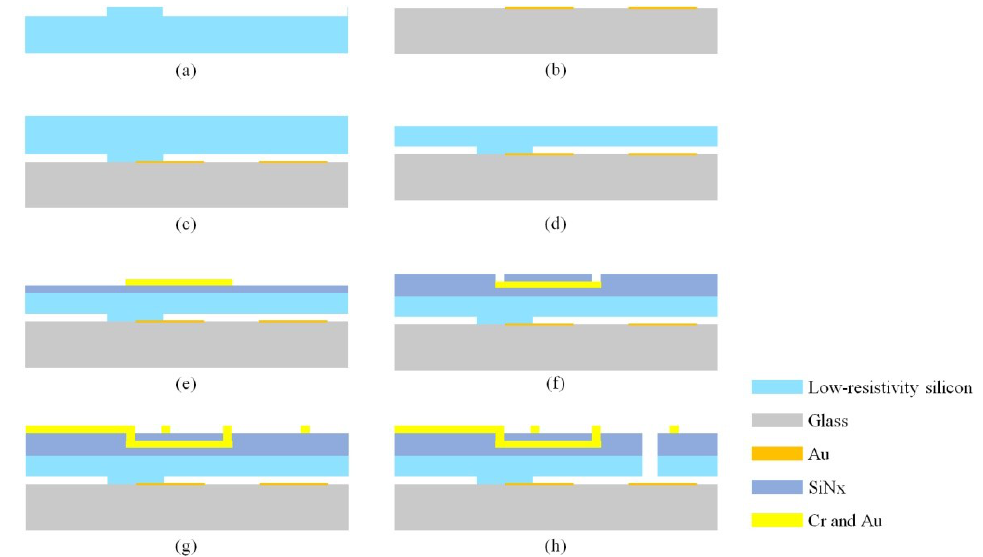
Figure 3. Fabrication process for the MEMS structures: ( a ) A step was etched on the backside of the low-resistivity silicon for glass–silicon bonding. ( b ) Fabrication of the metal plates on the glass substrate with the lift-off process. ( c ) The low-resistivity silicon was attached to the glass substrate through anodic bonding. ( d ) The silicon wafer was polished using chemical mechanical planarization (CMP). ( e ) Gold was patterned to fabricate the lead wire. ( f ) Silicon nitride (SiNx) was deposited for insulation. ( g ) Gold was patterned to fabricate the coil layer using plasma-enhanced chemical vapor deposition (PECVD). ( h ) The torsional structures were released with inductively coupled plasma (ICP).